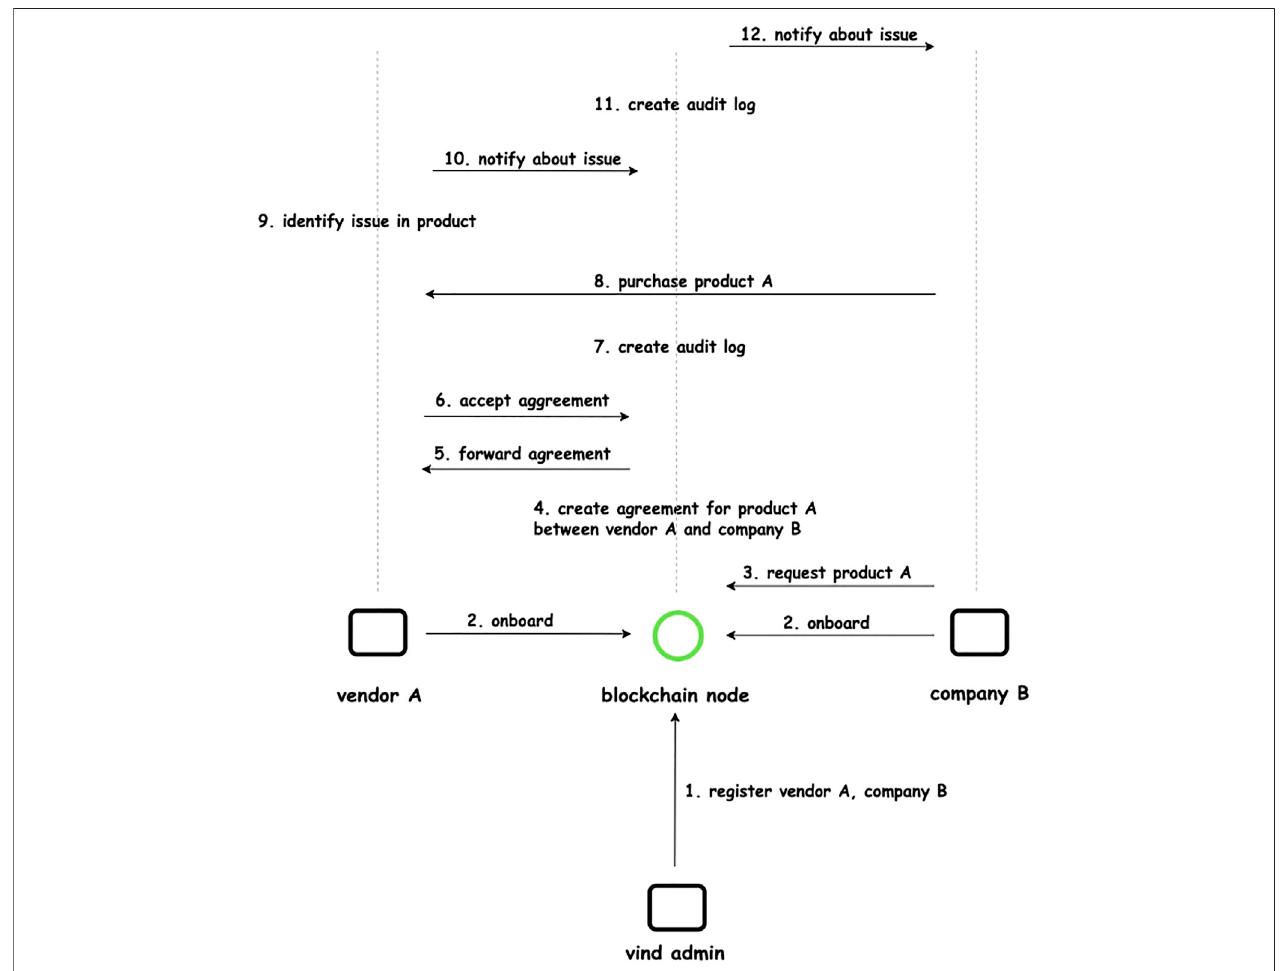
FIGURE 2 | Interaction diagram of ause case in Vind. Vind admin onboard vendors and companies into the platform. When a company purchases a product from the vendor, agreement will be formed. The noti fi cations regarding the products will be generated by vendors.